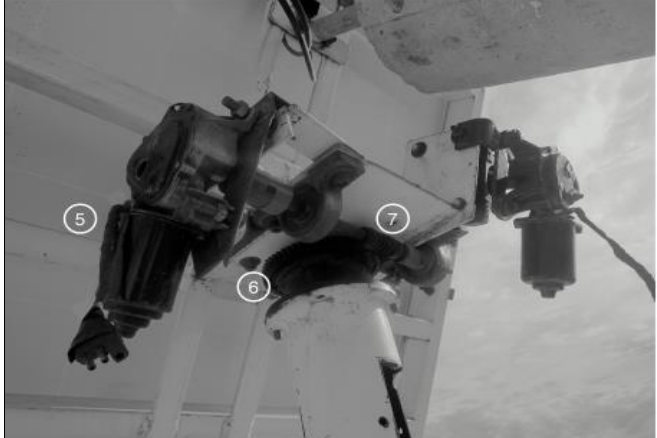
Figure 4: Parts of the azimuthal axis